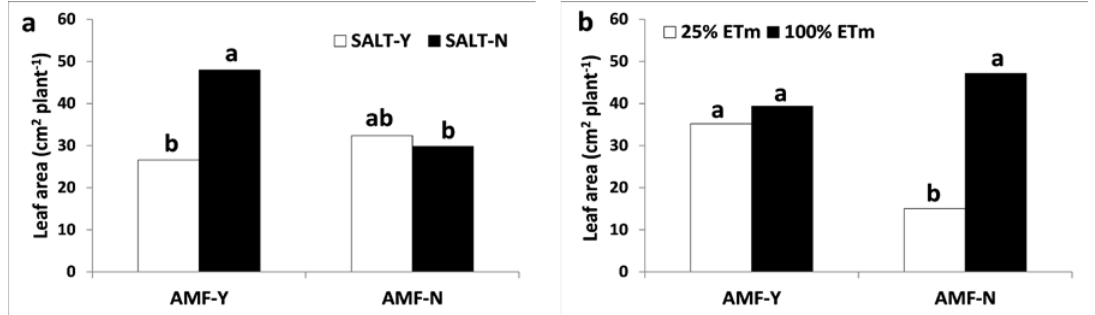
Figure 8. Effect of the studied factors on leaf area surface. ( a ) Salt X AMF inoculation; ( b ) ETm restitution X AMF inoculation. Different letters show statistical differences of the treatments at p < 0.05 (Least Significant Difference—Fisher test). AMF-Y = AMF-inoculated treatment; AMF-N = AMF uninoculated treatment; Salt-Y = treatment with NaCl addition in irrigation water; Salt-N = treatment without NaCl addition in irrigation water; 25% ETm = restitution of crop evapotranspirated water at 25%; 100% ETm = restitution of crop evapotranspirated water at 100%.